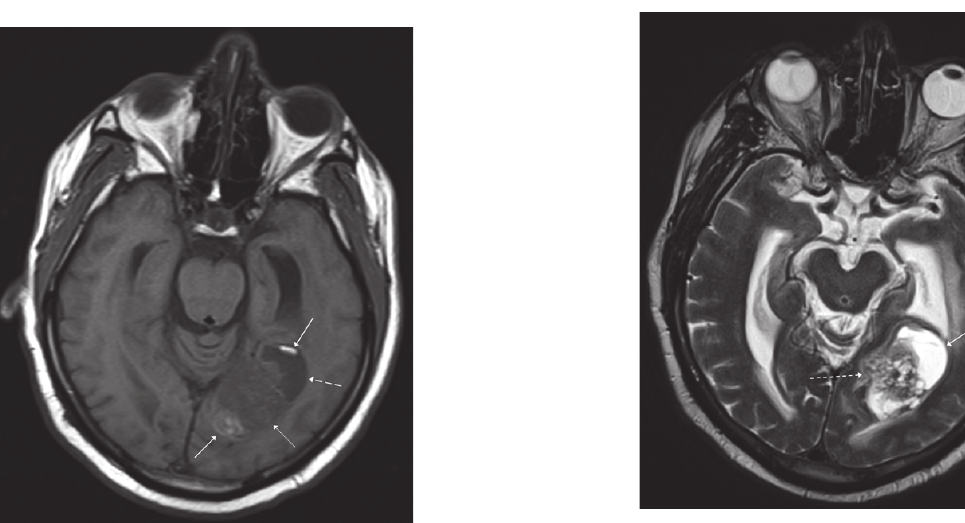
Figure 4: T2 weighted axial image shows a mixed solid (dashed white arrow) and cystic (solid white arrow) temporooccipital mass with a heterogeneous, bubbly appearance of the solid